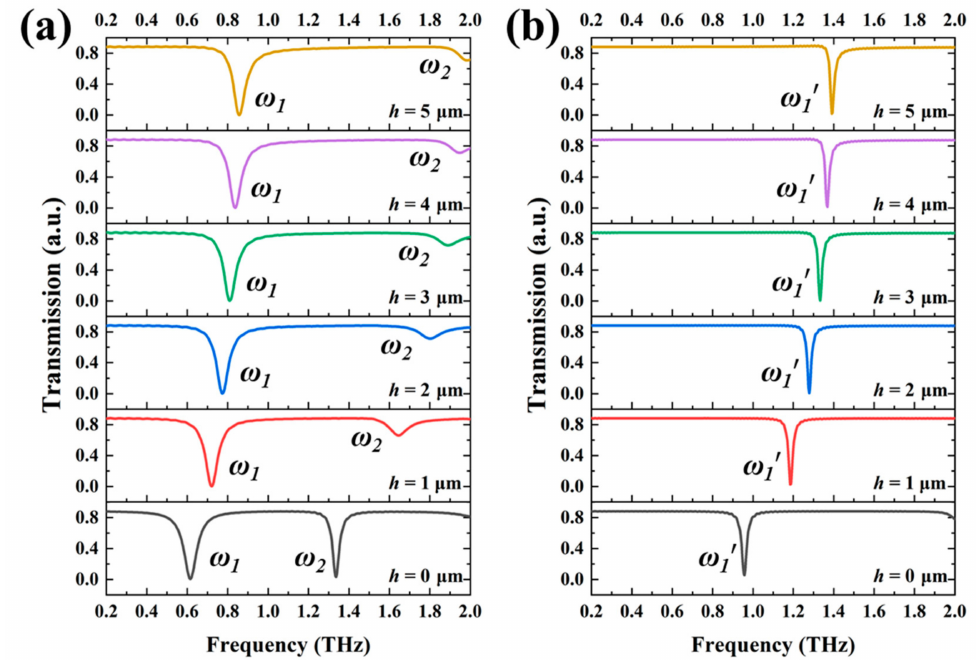
Figure 3. Transmission spectra of ( a ) SRR-3 and ( b ) SRR-4 by changing h parameter from 0 µ m to 5 µ